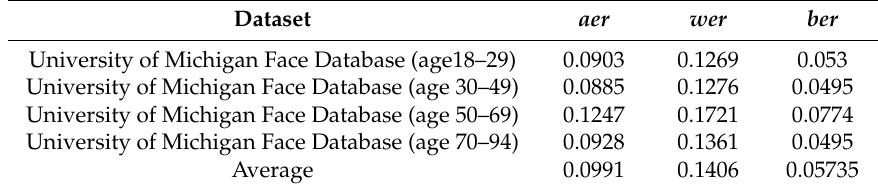
Table 3. Iris radius computation results on the University of Michigan Face